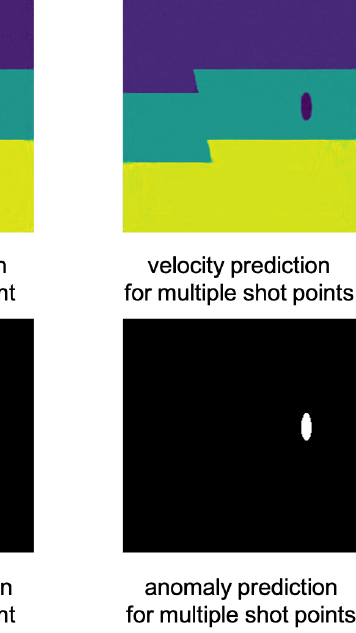
Figure 11. Prediction for velocity field and anomaly with one anomaly and fault.